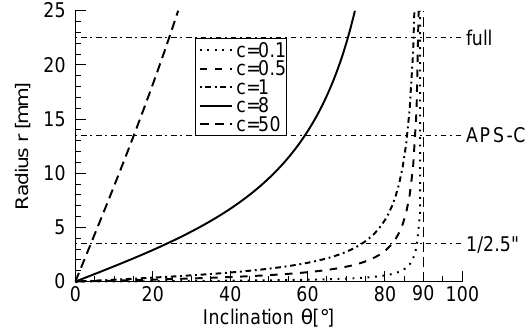
Figure 2: Perspective camera